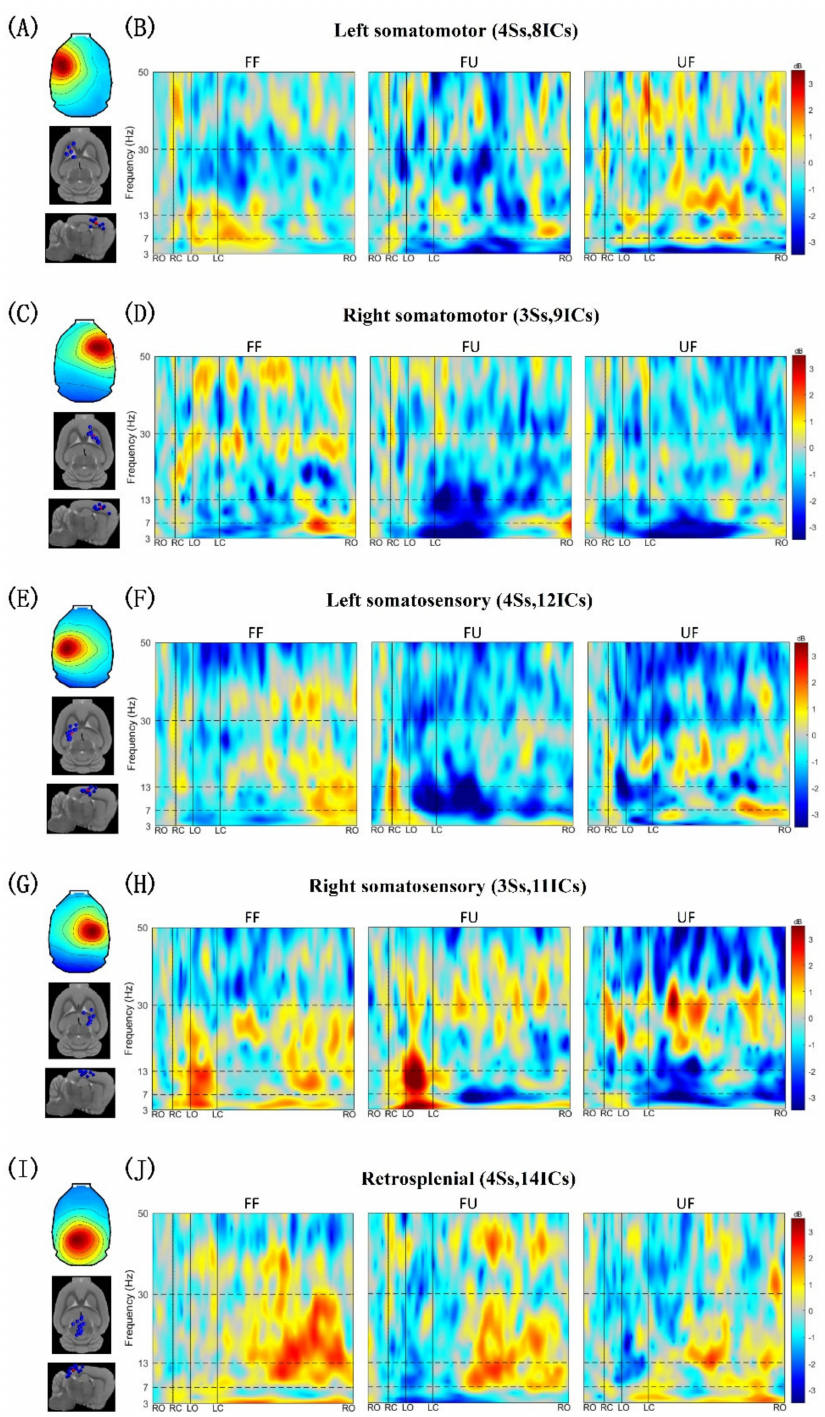
Figure 4. Equivalent dipole source locations, cluster mean scalp projections, and mean ERSP im- ages for IC source clusters centered in the left and right somatomotor clusters, the left and right somatosensory clusters and the retrosplenial cluster. ( A , C , E , G , I ) Cluster mean scalp projection map and equivalent dipole locations of cluster ICs (blue spheres) and their centroid (red sphere) visual- ized in the MNI template brain. ( B , D , F , H , J ) Cluster mean ERSP images of rats under the different conditions (FF, FU, UF). Warm colors indicate a power increase (ERS) and the cool colors indicate a power decrease (ERD). Non-significant changes from the baseline are masked in gray ( p > 0.05). Solid vertical lines indicate the time of the gait